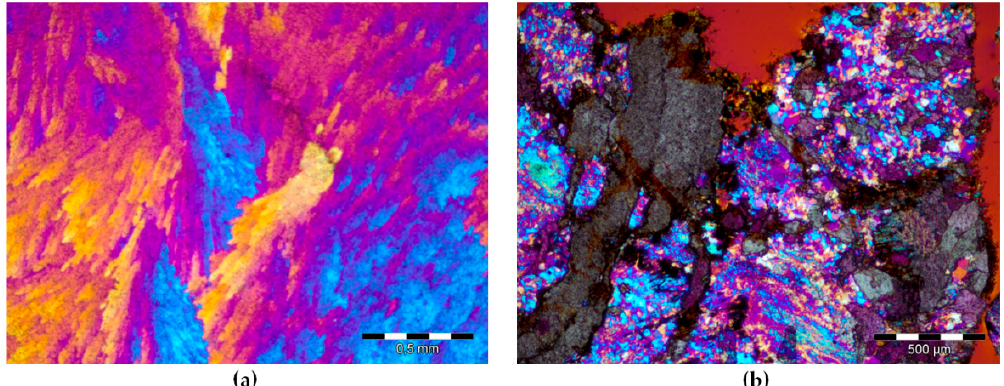
Figure 2. Barite aggregates in XPL_G: ( a ) B1 with characteristic plumose structure of BaSO 4 ; ( b ) B2 with microcrystalline quartz and cristobalite; (scale bar = 500 μ m).